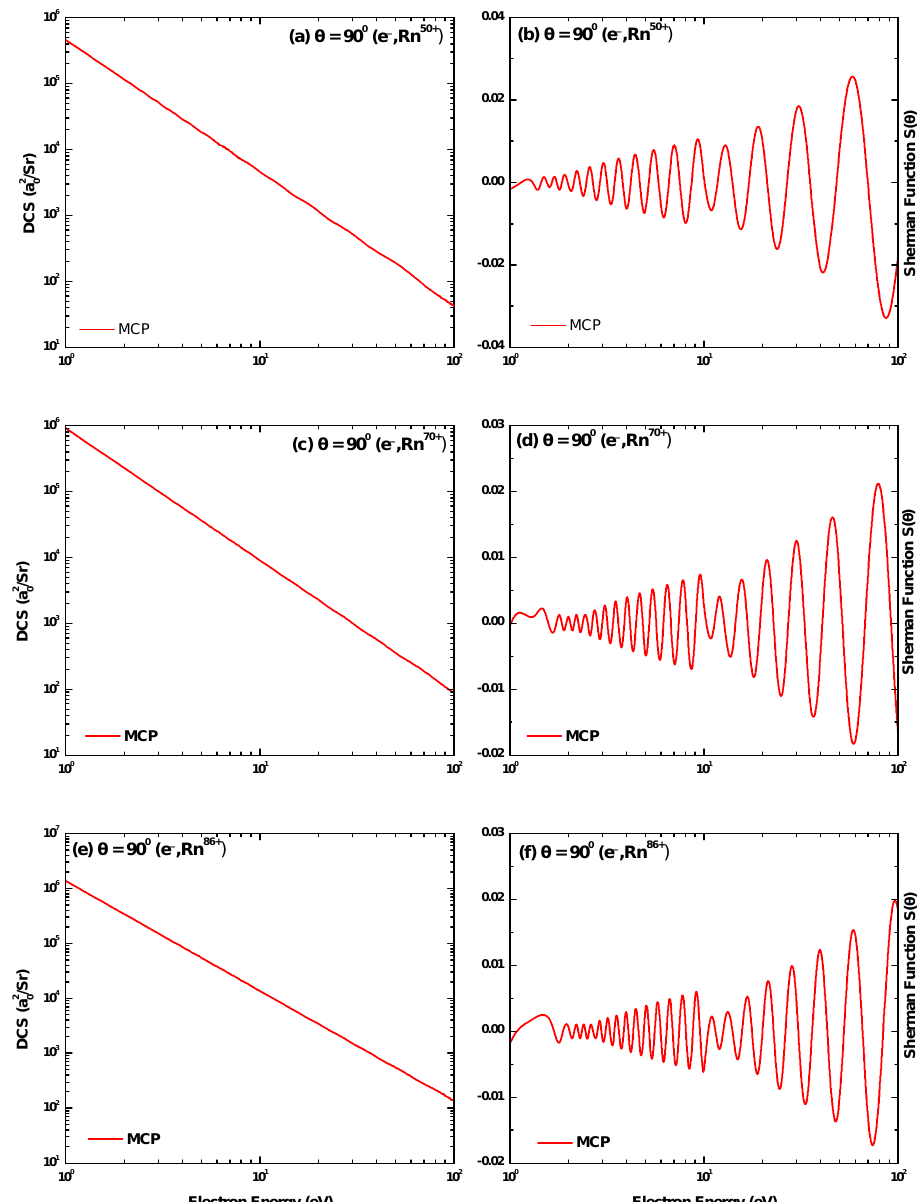
Figure 27. Energy dependent DCS and corresponding Sherman function for the elastic scattering of electrons from ( a , b ): Rn 50 + , ( c , d ): Rn 70 + and ( e , f ): Rn 86 + at fixed scattering angle θ = 90 ◦